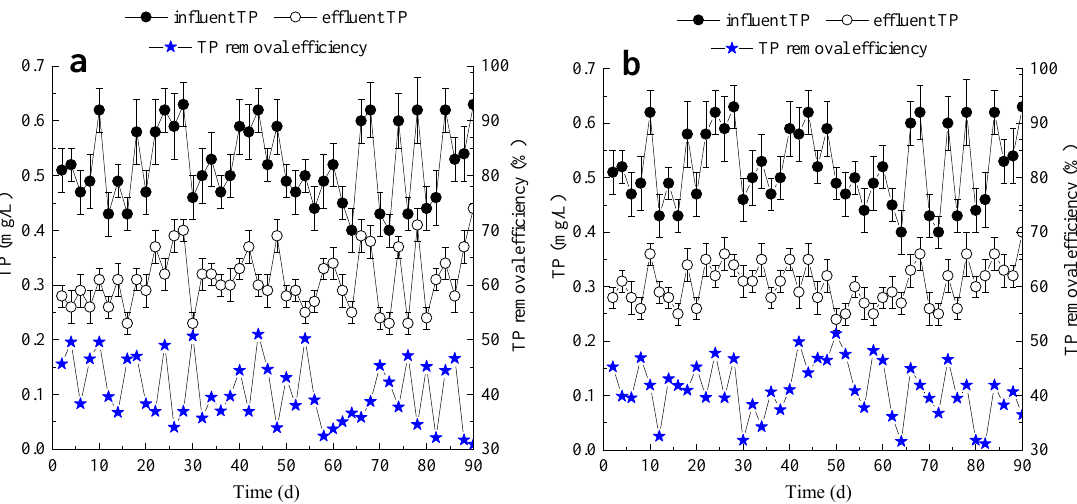
Figure 8. Total phosphorus (TP) removal performances in the VFCW ( a ) and HFCW ( b ) ecosystems under different influent loads. The results were the averages and their standard deviations.